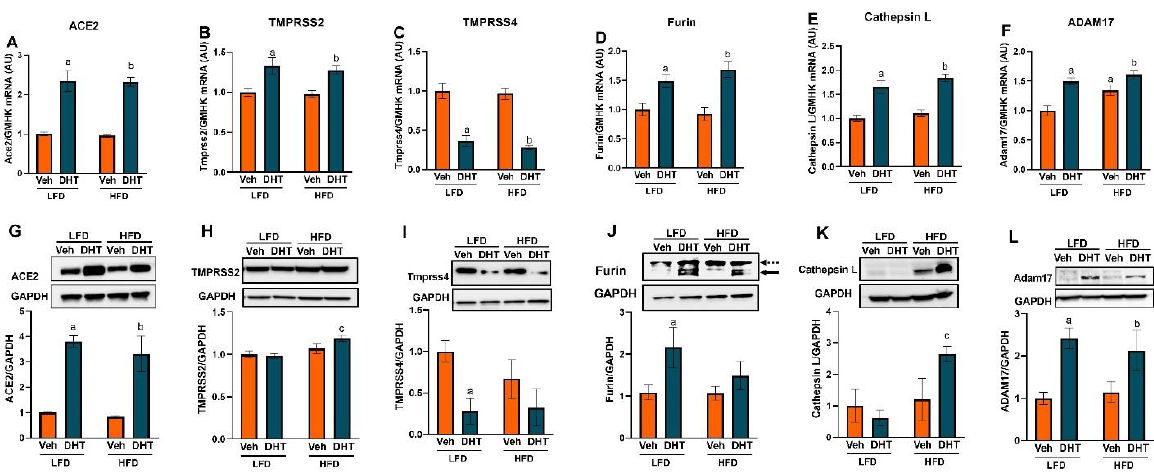
Figure 4. Effect of DHT and diet on renal SARS-CoV-2 viral entry proteins expression. Animals were treated with dihydrotestosterone (DHT) or vehicle (Veh) and maintained in low (LFD) or high (HFD) fat diet for 90 days. Ace2 ( A ), Tmprss2 ( B ), Tmprss4 ( C ), furin ( D ), cathepsin L ( E ), and ADAM17 ( F ) mRNA was quantified by RT-qPCR and standardized to the geometric mean of four housekeeping genes (HGMK) ( N = 6–8/group). ACE2 ( G ), TMPRSS2 ( H ), TMPRSS4 ( I ), furin ( J ), cathepsin L ( K ), and ADAM17 ( L ) protein was quantified by Western-blot and normalized to GAPDH ( N = 4/group). Total furin ( J ) was quantified as the sum of profurin (dashed arrow) and cleaved soluble furin (solid arrow). Data are expressed as mean ± SEM. Data were analyzed by two-way ANOVA followed by Fisher’s LSD test. a p < 0.05 vs. LFD-Veh; b p < 0.05 vs. LFD-Veh; c p < 0.05 vs. LFD-DHT.